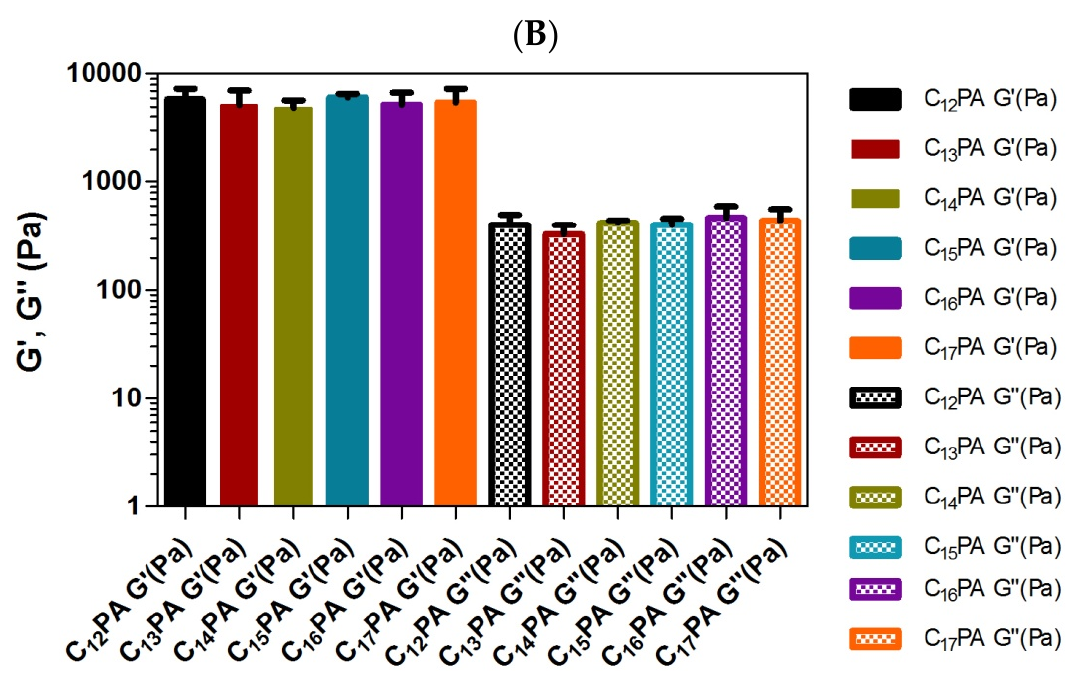
Figure 4. ( A ) Dynamic time sweep oscillatory rheology measuring the storage modulus (G′, filled circles) and loss modulus (G′′, filled triangles) of 1% ( w / v ) PA solutions after initiating self-assembly. ( B ) G′ and G′′ values of PA gels at equilibrium (mean ± SD, n = 3). The measurements were performed in viscoelastic region at constant strain (0.01%) and angular frequency (10 rad/s).